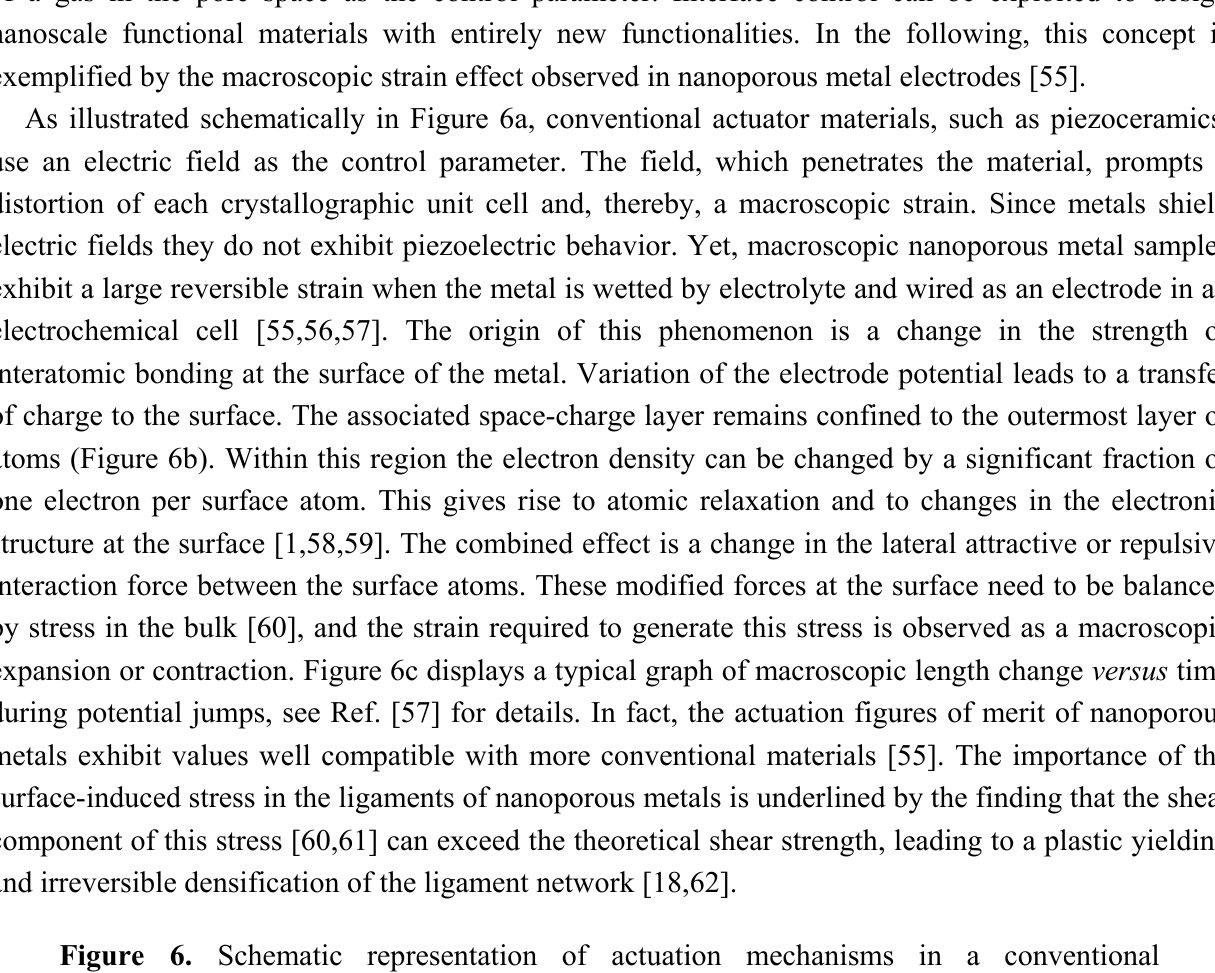
piezoceramic (a) and in a nanoporous metal (b). Response of the macroscopic